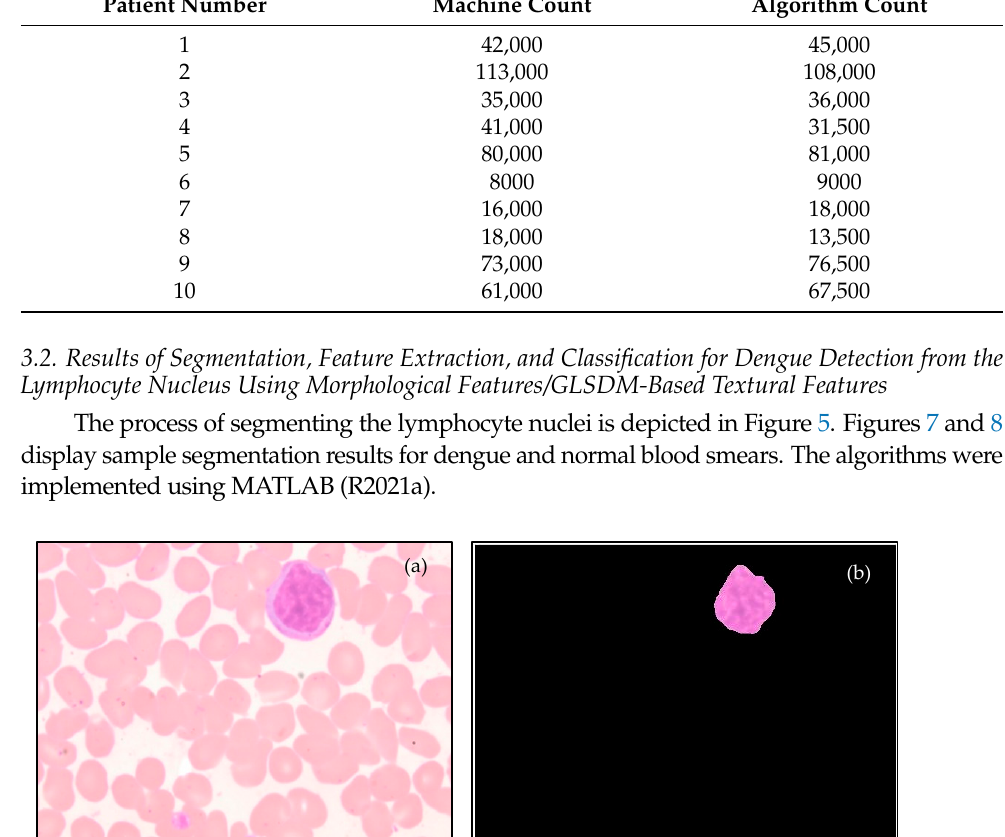
Figure 8. Sample results of segmentation process: ( a ) Normal lymphocyte, and ( b ) Segmented nu- cleus. After segmentation, six morphological and four GLSDM features, including Area, Perimeter, Major Axis Length, Minor Axis Length, Eccentricity, Circularity, Contrast, En- ergy, Correlation, and Homogeneity were extracted out of the nucleus of normal and den- gue-infected lymphocytes. Then, a feature matrix was created using Microsoft Excel with columns as the different features and rows as the different samples. Subsequently, the feature matrix was normalized and fed to the classifiers. Six classifiers (DT, LDA, NB, SVM, KNN, and MLP) were trained and tested. The MATLAB Classification Learner Toolbox (MCLT) was employed to implement the classifiers. The best result was obtained using SVM and DT classifiers. The hyper-parameters used to build these six classifiers are recorded in Table 1. Figure 9 depicts the Confusion matrices and Receiver operating char- acteristic (ROC) curves that were derived from SVM/DT classifiers with 10-fold cross-val- idation. In the confusion matrix, ‘1’ denotes dengue-infected class, and ‘2’ denotes normal class.